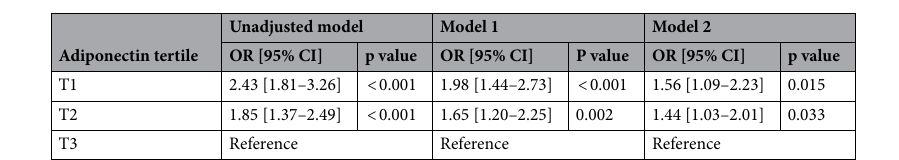
Table 2. Multivariate analysis of the association between serum adiponectin tertile and high physical component summary (PCS). Model 1: Adjusted for age, sex, body mass index, marriage, economy, education, systolic blood pressure, diabetes, dyslipidemia, cardiovascular disease, estimated glomerular filtration rate, urine protein to creatinine ratio, C-reactive protein, hemoglobin, and albumin. Model 2: Adjusted for Model 1 + current smoking, alcohol, and physical activity.